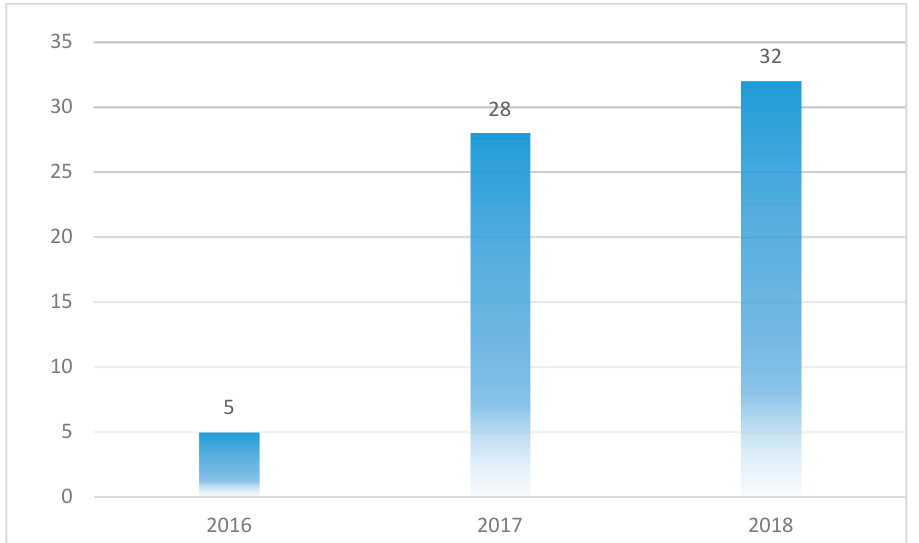
Healthcare 2019 , 7 , x